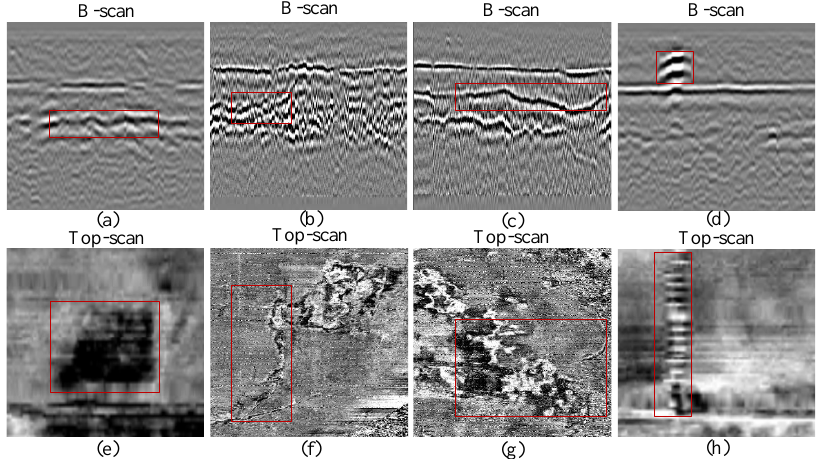
Figure 2. Typical GPR patterns of void, crack, subsidence, and pipe: B-scan images of a ( a ) void; ( b ) crack; ( c ) subsidence; and ( d ) pipe. Top-scan images of a ( e ) void; ( f ) crack; ( g ) subsidence; and ( h )